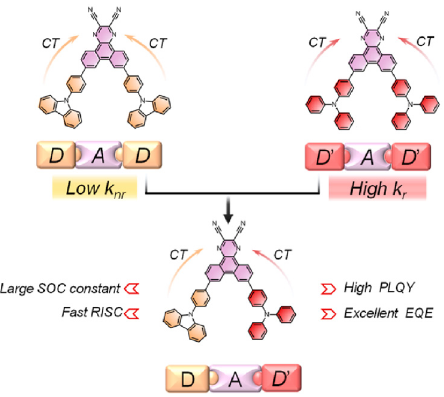
Figure 17. Chemical structures of M50 to M57 .